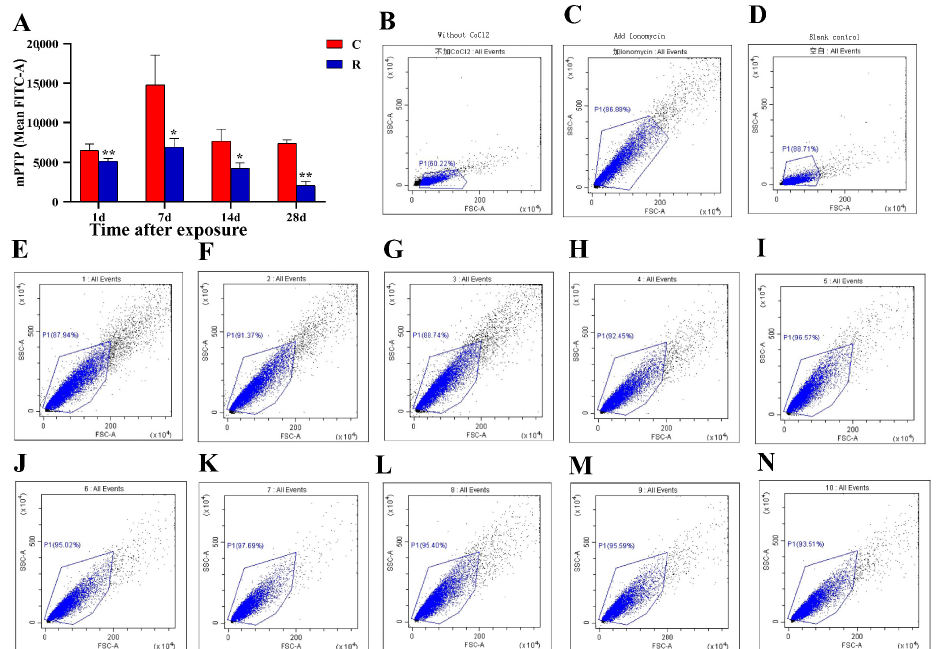
Figure 3. Changes in myocardial mPTP in rats after S-band radiation. ( A ) Statistical analysis graph; ( B ) flow diagram of negative control on Day 14; ( C ) flow diagram of positive control on Day 14; ( D ) flow diagram of blank control on Day 14; ( E – I ) flow diagrams of Group C on Day 14; ( J – N ) flow charts of Group R on Day 14. Significance signs were classified according to p -value: * p < 0.05 and ** p < 0.01.